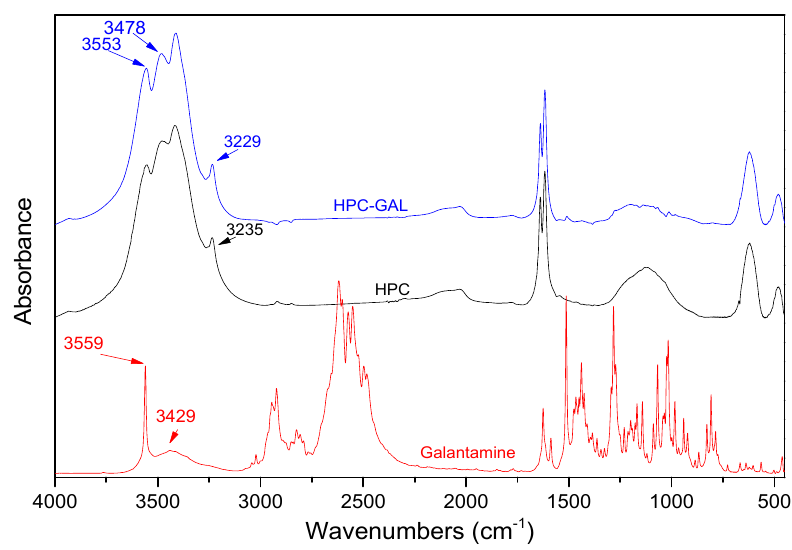
Figure 3. FT-IR spectra of the HPC, the galantamine, and of the mixture after adsorption.